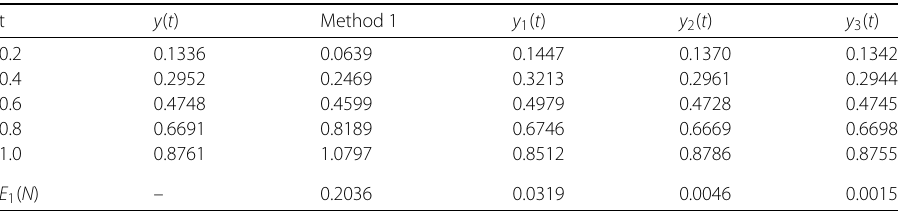
Table 5 A comparison between the proposed method of this paper and the method proposed in [29], (Method 1), with N = 1,2,3 for α =